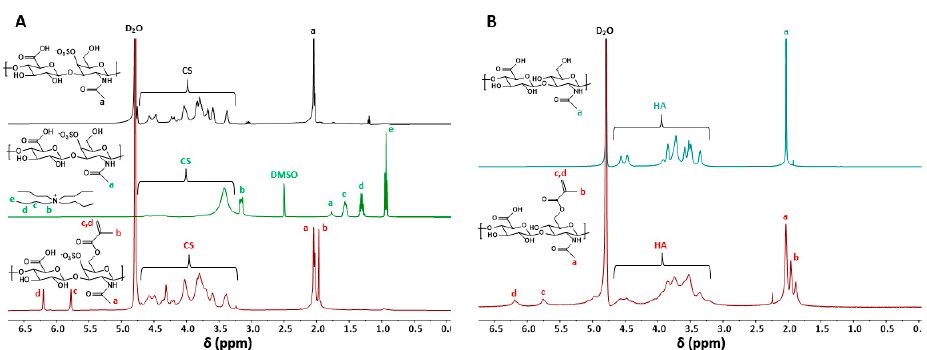
Figure 1. ( A ) H ‐ NMR spectra of CS (top) in D 2 O, CS ‐ TBA (middle) in DMSO d ‐ 6, and CSMA (bottom) in D 2 O. ( B ) H ‐ NMR spectra of HA (top) in D 2 O and HAMA (bottom) in D 2